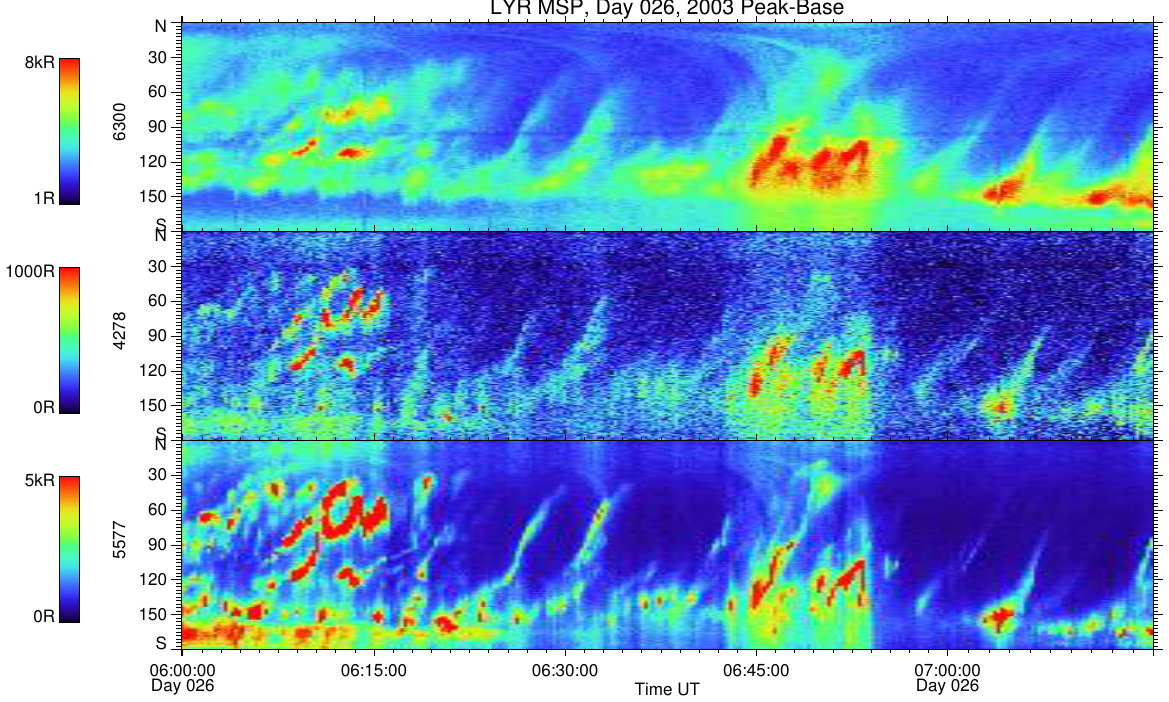
Fig. 2. Meridian scanning photometer data from event 4 (26 January 2003, 06:53 UT), The panels show the 630.0-nm (red), 427.8-nm (blue) and 557.7-nm (green) emissions in kR, from top to bottom, respectively. Around the time of the event there are fairly strong red emissions, which in the absence of other optical instruments, easily could have been interpreted as northward moving red arcs. The radar is pointing just south of the 90 ◦ scanning elevation